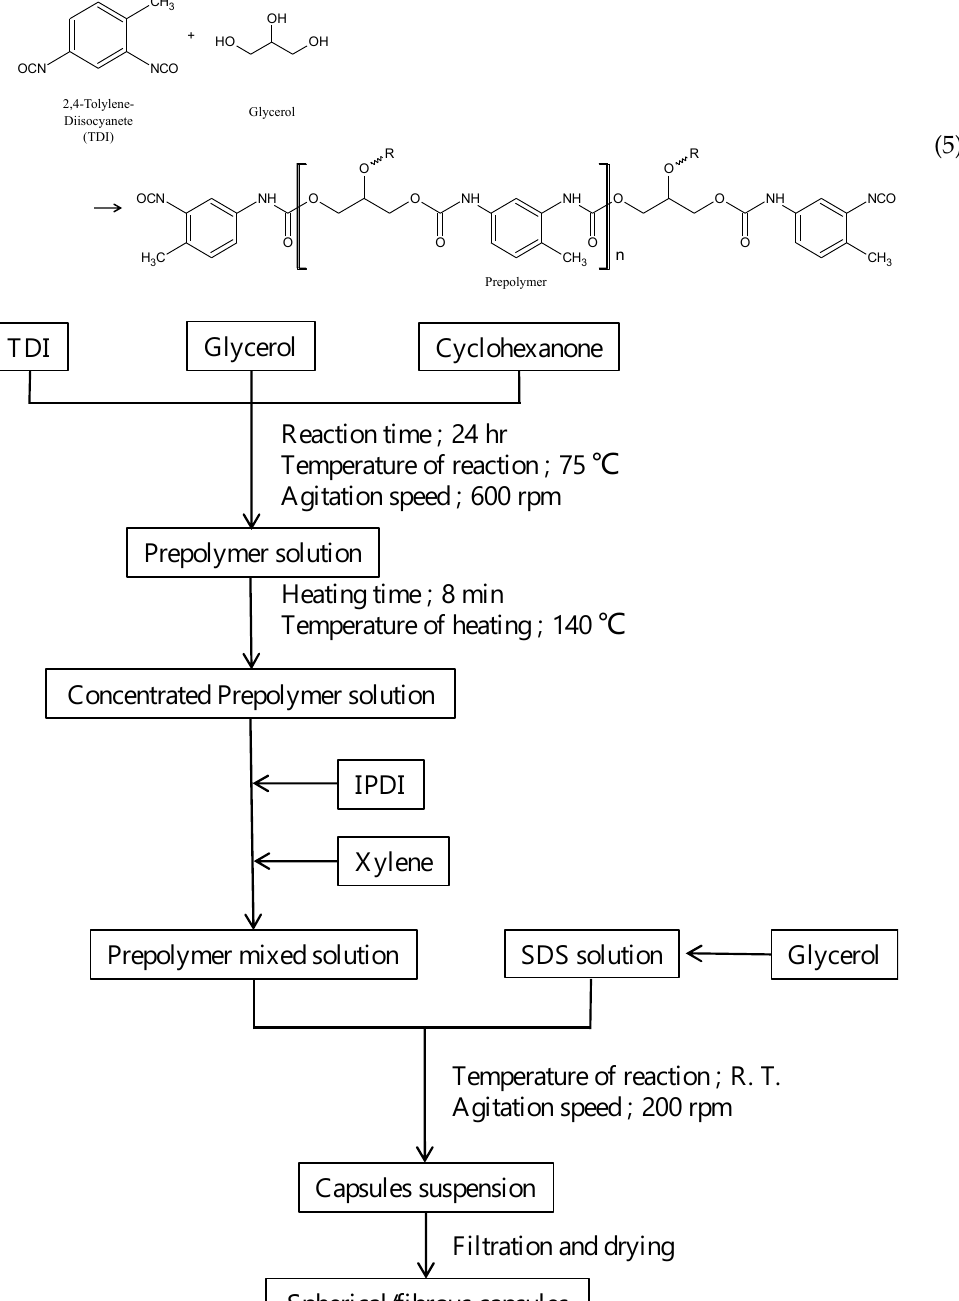
Figure 4. Flow diagram of the formation of spherical and fibrous capsules containing the healing agent, IPDI.